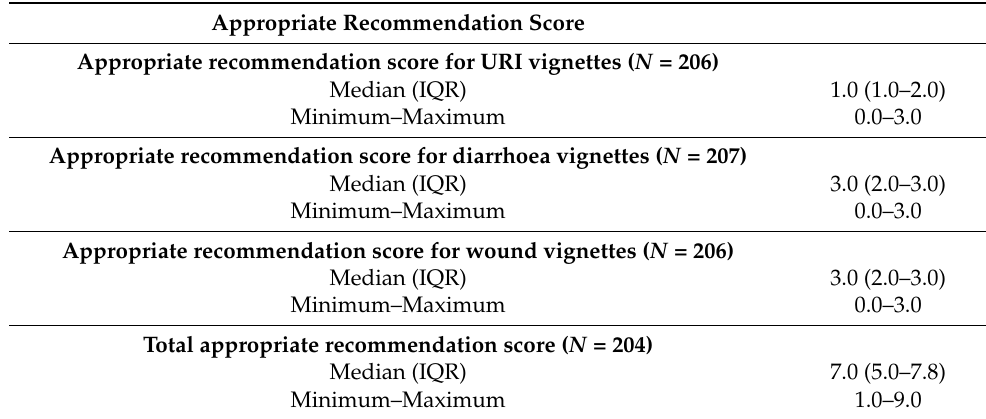
Table 4. Appropriate recommendation score for community pharmacists in relation to antibiotics.